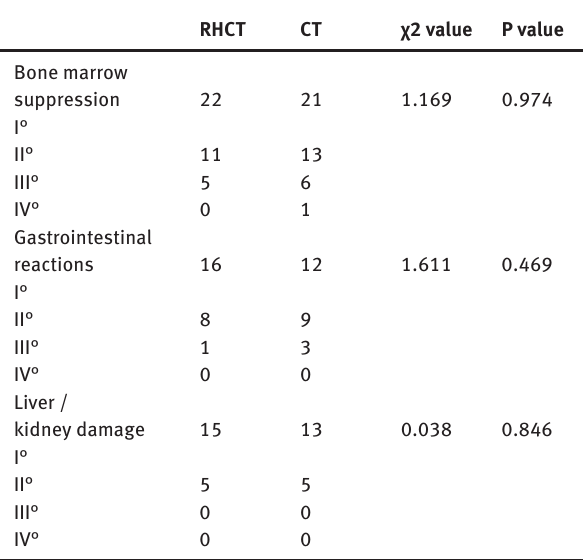
Table 3: Comparisons of adverse reactions in the two